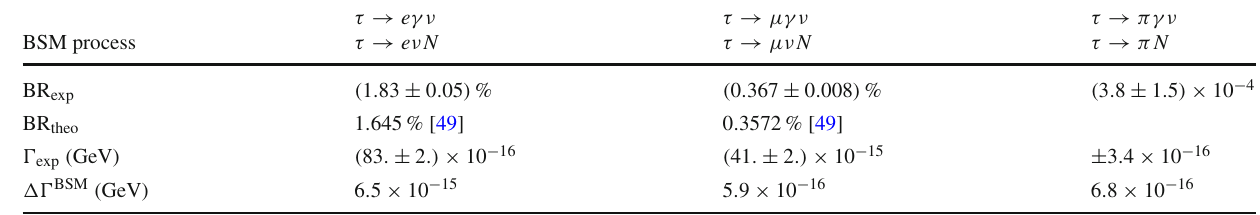
ing ratio into decay width and list the allowed contribution from BSM processes according to Eq. (4.5). Note the discrepancy between theory and experiment in the τ → e ν N